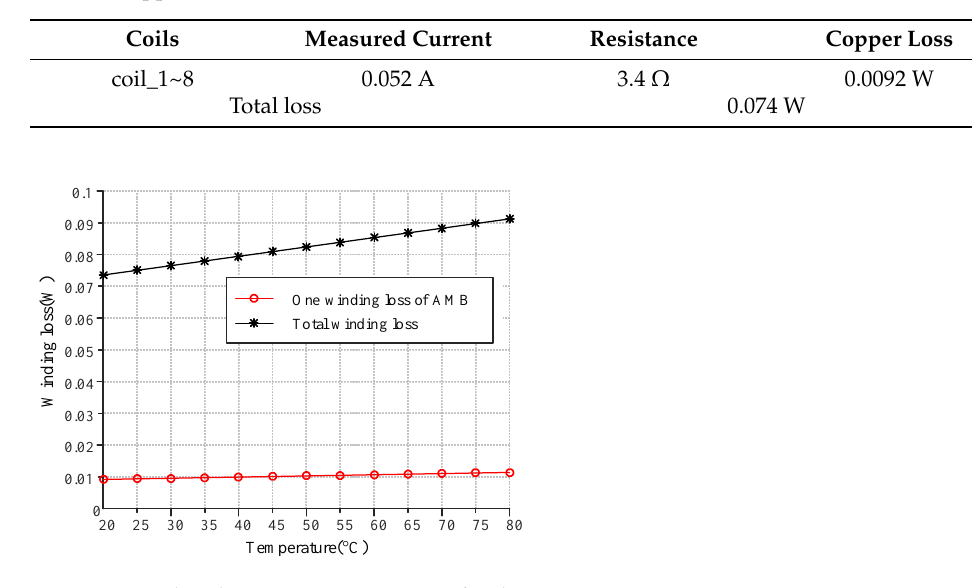
Figure 7. Winding loss versus temperature for the AMB.